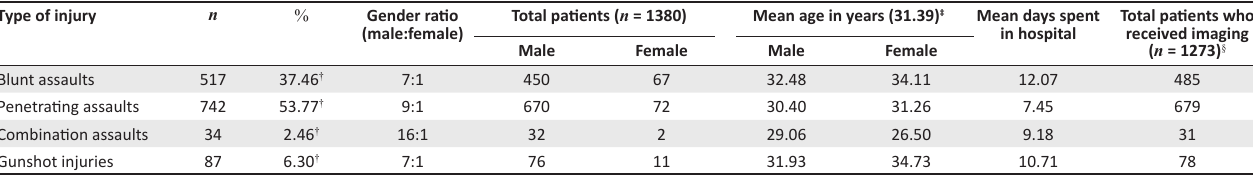
TABLE 2: Descriptive statistics.